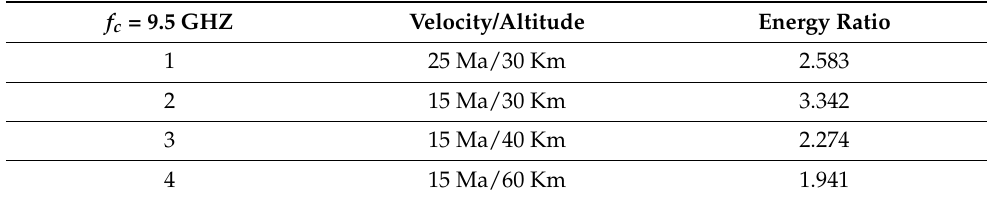
Table 3. Improved algorithm processing results.